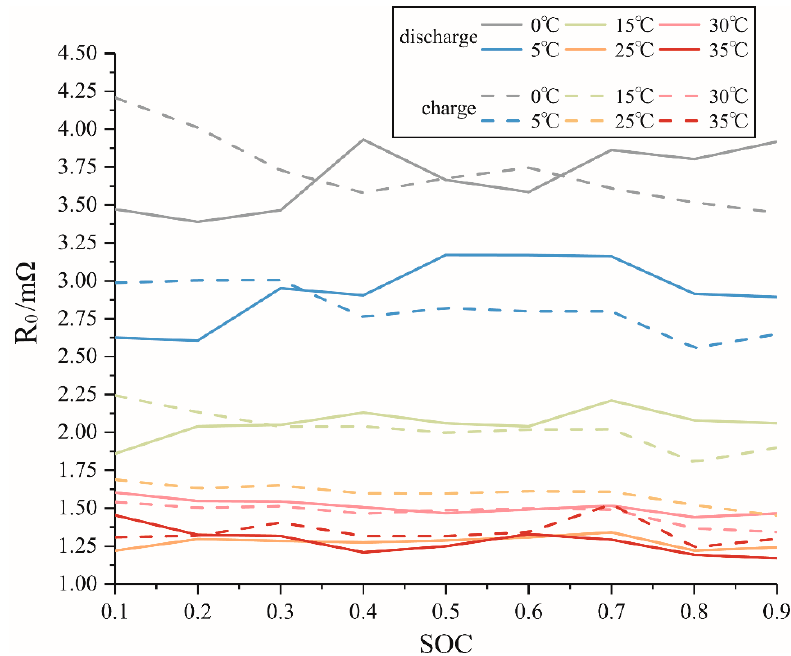
Figure 11. Evolution of the internal resistance R 0 as a function of SOC at different temperatures in the range 0–35 °C.